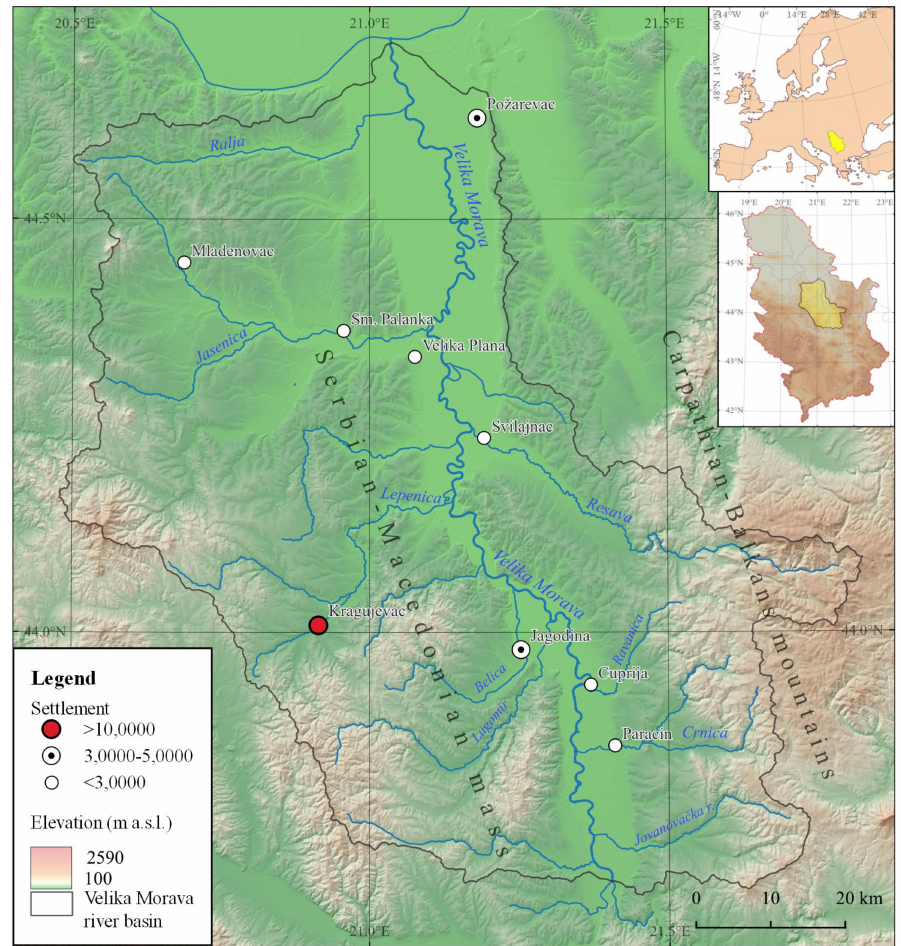
Figure 1. Geographical position of the Velika Morava River